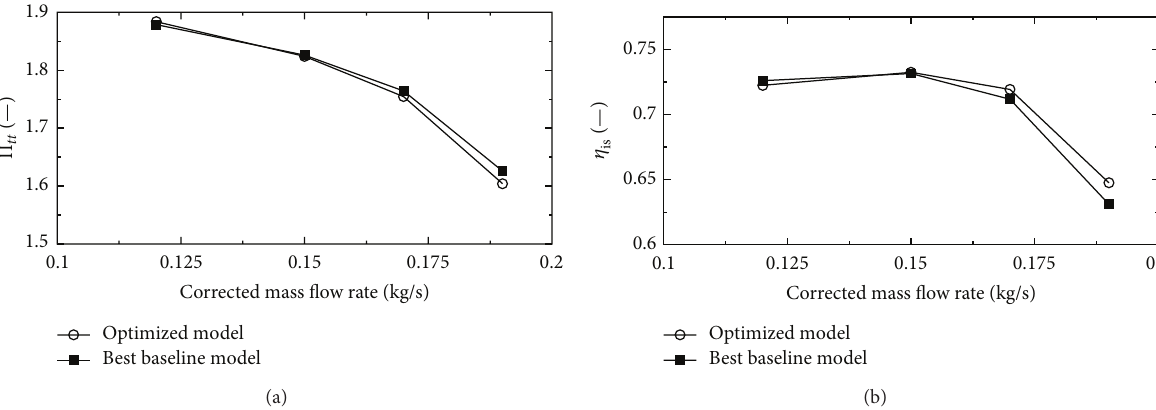
Figure 15: Total pressure ratio (a) and isentropic efficiency (b) at 𝑛 = 100,000 min −1 for the best baseline and optimized volute shape. 0.30.40.50.6